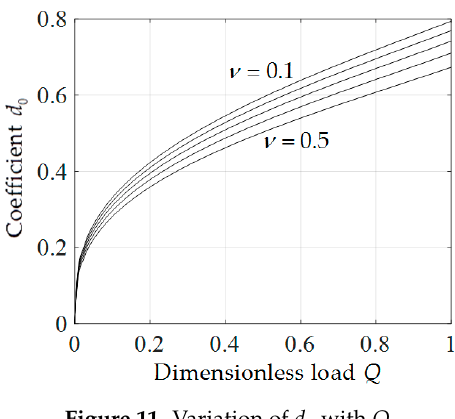
Figure 11. Variation of d 0 with Q .